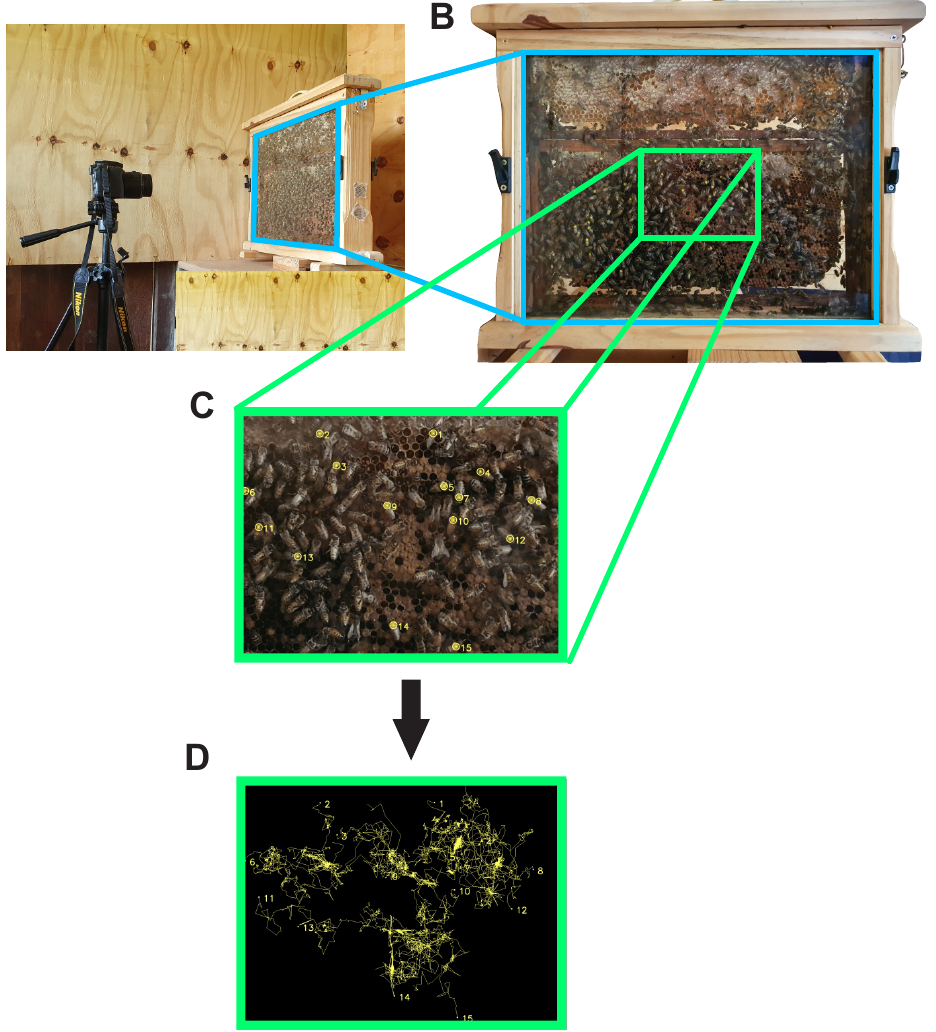
Figure 1. Representation of the video recording setup. An observation beehive (wooden frame with 52.5 cm x 43.5 cm) covered on the laterally with plate glass allowed the video recording of the colony. A lateral view ( A ) and a frontal view ( B ) of the experimental setup are presented. Marked workers were detected using a background subtraction algorithm and color picking ( C ). By using a Bayesian multi-target strategy, we tracked the trajectories traveled by labeled workers (either pesticide-unexposed or sublethally exposed to commercial fungicide formulation) ( D